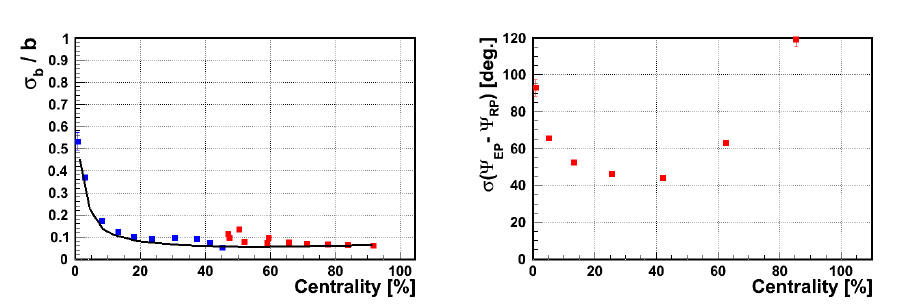
Figure 7. (Left) Dependence of centrality resolution of FHCal as function of centrality. (Right) The reaction plane angle resolution for FHCal with beam